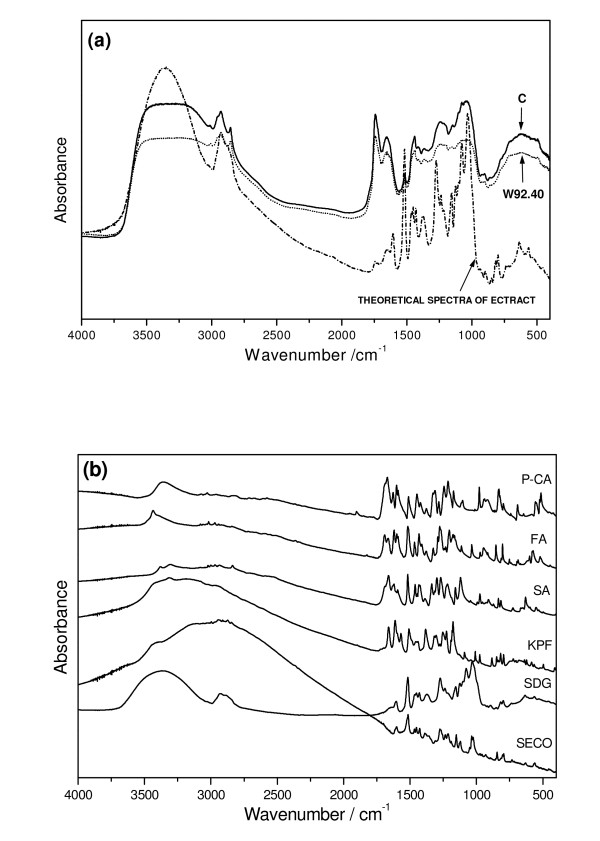
The IR analysis of seedcake extracts. The IR spectra of the (a) seedcake extracts obtained from the control(C) and transgenic (W92.40) flax plants; (b) The IR spectra of standards: seicoisolarisiresinole (SECO), seicoisolarisiresinol diglucoside (SDG), kaempferol (KPF), sinapic acid (SA), ferulic acid (FA), p-coumaric acid (P-CA)